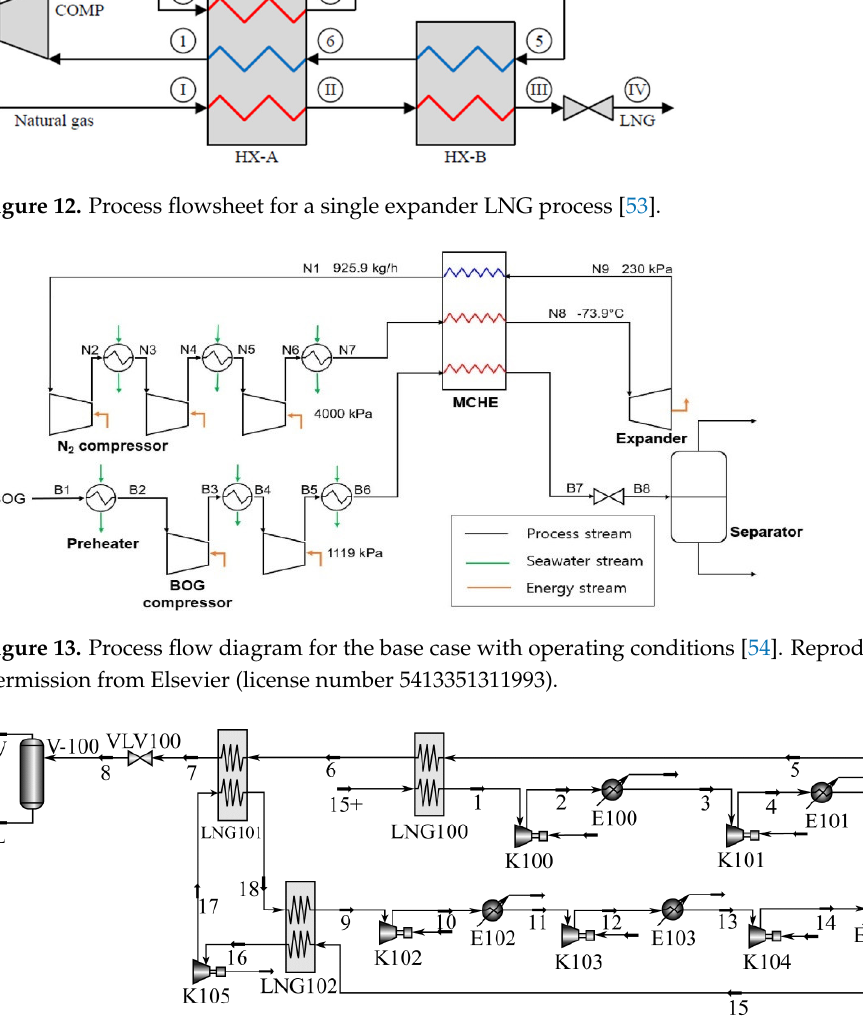
Reproduced with permission from Elsevier (license number 5413360219443). Figure 14. Process flow for boil-off gas (BOG) re-liquefaction nitrogen expansion liquefaction pro- cess [55].